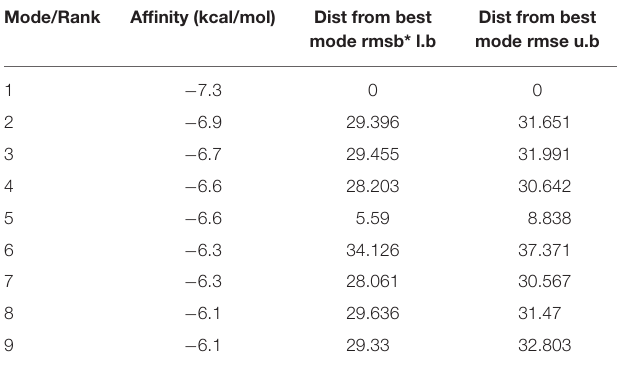
TABLE 2 | MOE score of h P2Y12 protein and curcumin (kcal/mol). Mode/Rank Affinity (kcal/mol) Dist from best mode rmsb*